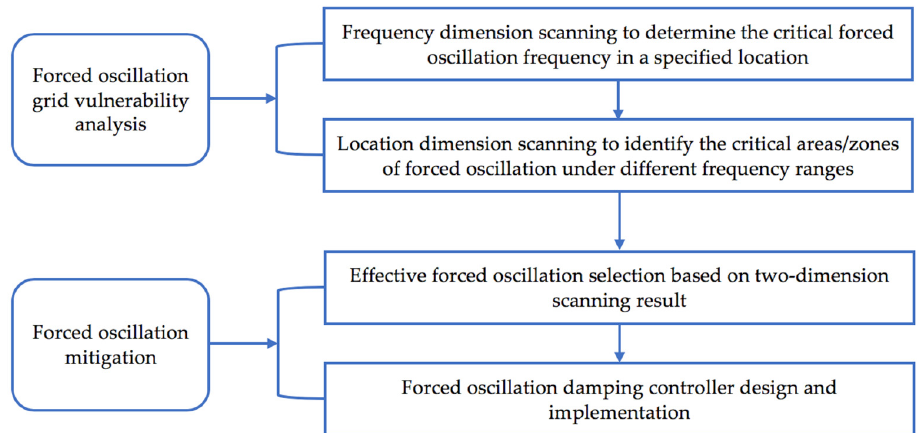
Figure 1. Framework of the forced oscillation identification and mitigation procedure.